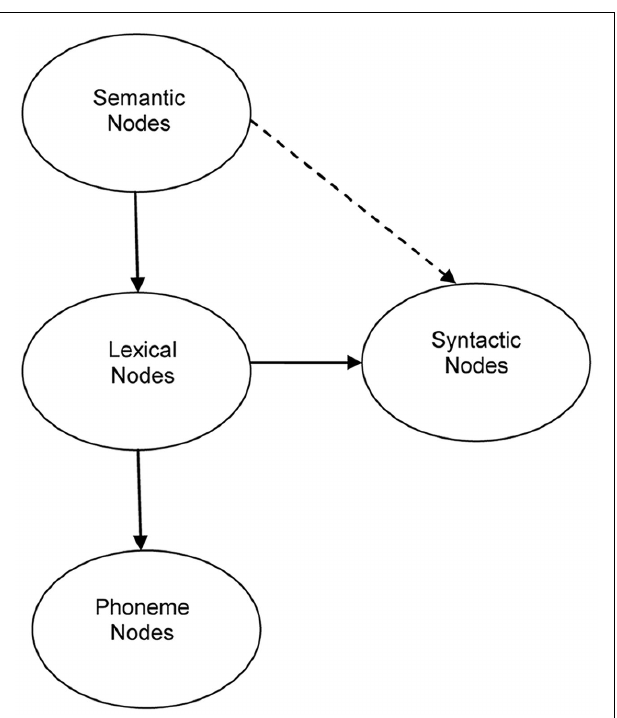
FIGURE 1 |A schematic representation of the functional architecture of lexical information processing in spoken word production according to current influential theories of lexical production (Caramazza, 1997 ; Levelt et al., 1999). The link represented in dotted line is assumed only in Caramazza’s (1997)